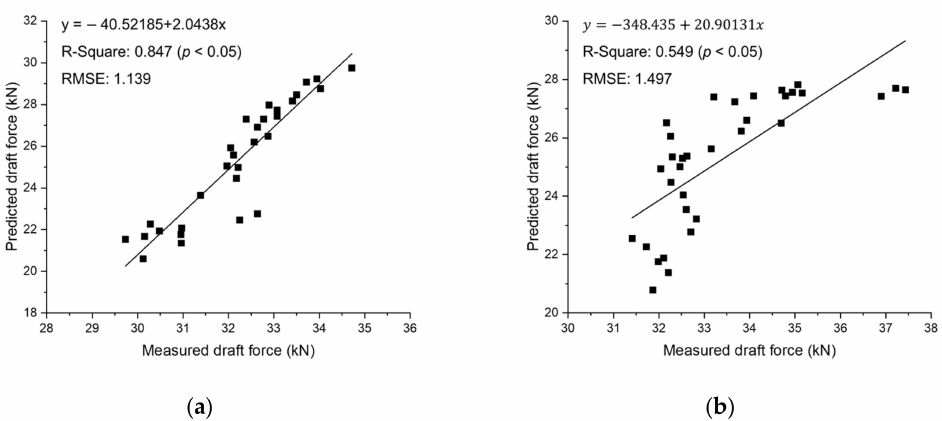
Figure 10. Results of linear regression between the measured draft force and the predicted values based on ASABE standard equation at ( a ) M3–low; and ( b ) M3–high.